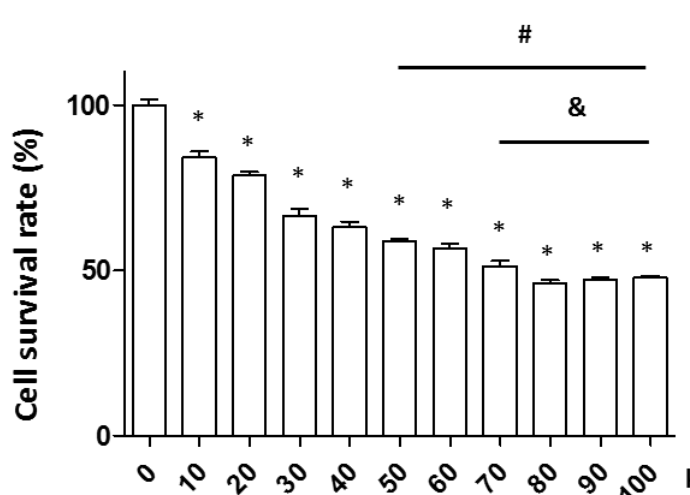
Figure 1. Neuronal cell survival rate in various concentrations of H 2 O 2 . Cells were treated with various concentrations of H 2 O 2 (0, 10, 20, 30, 40, 50, 60, 70, 80, 90, or 100 µ M) and cell viability was measured by the tetrazolium salt (WST) assay. The data shown are means ± standard error of the mean (SEM). *: p < 0.05 vs. 0 µ M, #: p < 0.05 vs. 30 µ M, and &: p < 0.05 vs. 40 µM.